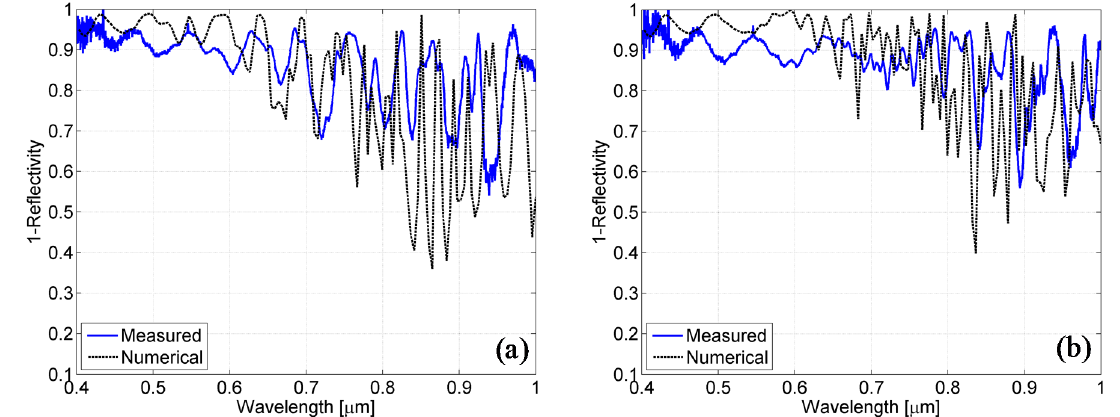
Figure 10. Comparison between the spectra obtained from the simulation using the first model (dotted black line) and those measured on the cells (solid blue line) for the cell grown on the textured superstrate with a nominal thickness of silicon of 800 nm ( a ) and for that of 1500 nm ( b ).